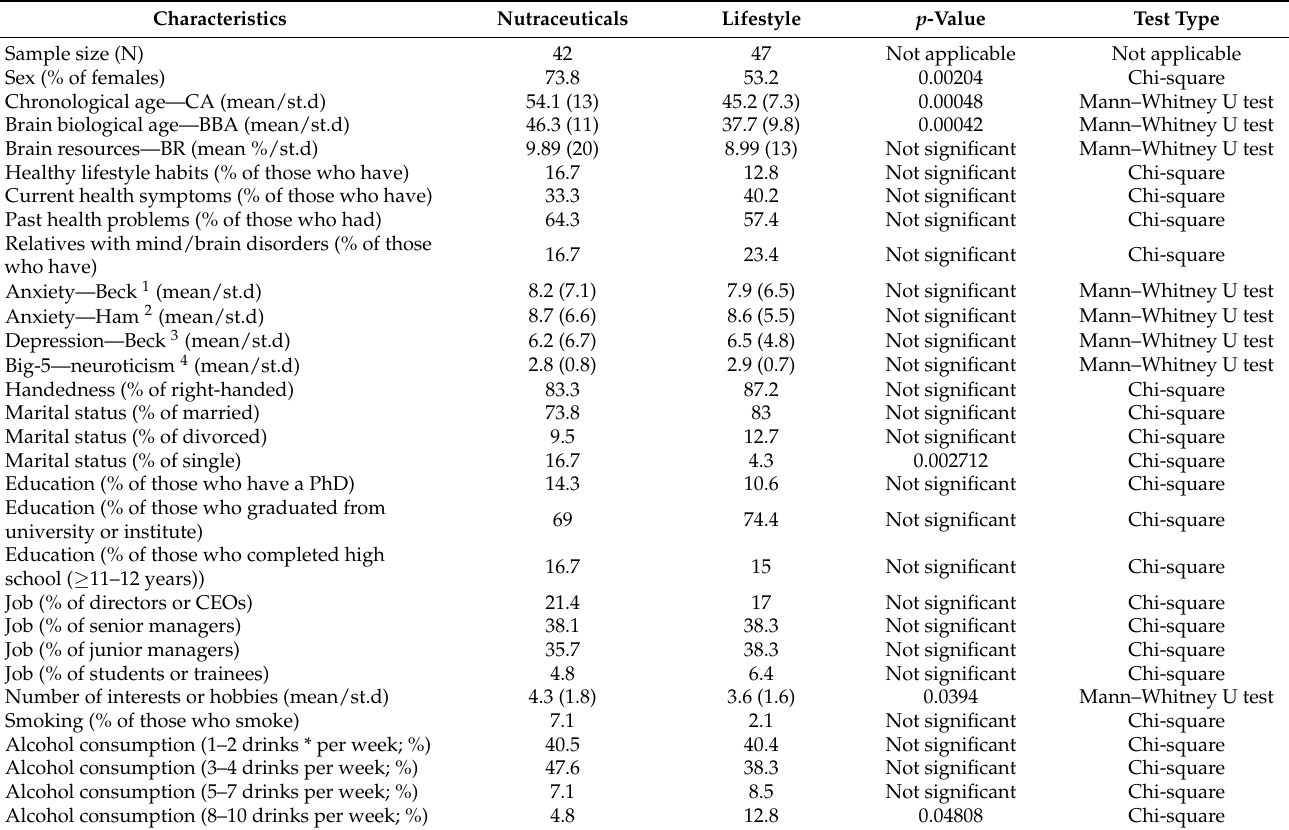
Table 1. Demographic and clinical data for the experimental (nutraceuticals) and active control (lifestyle)